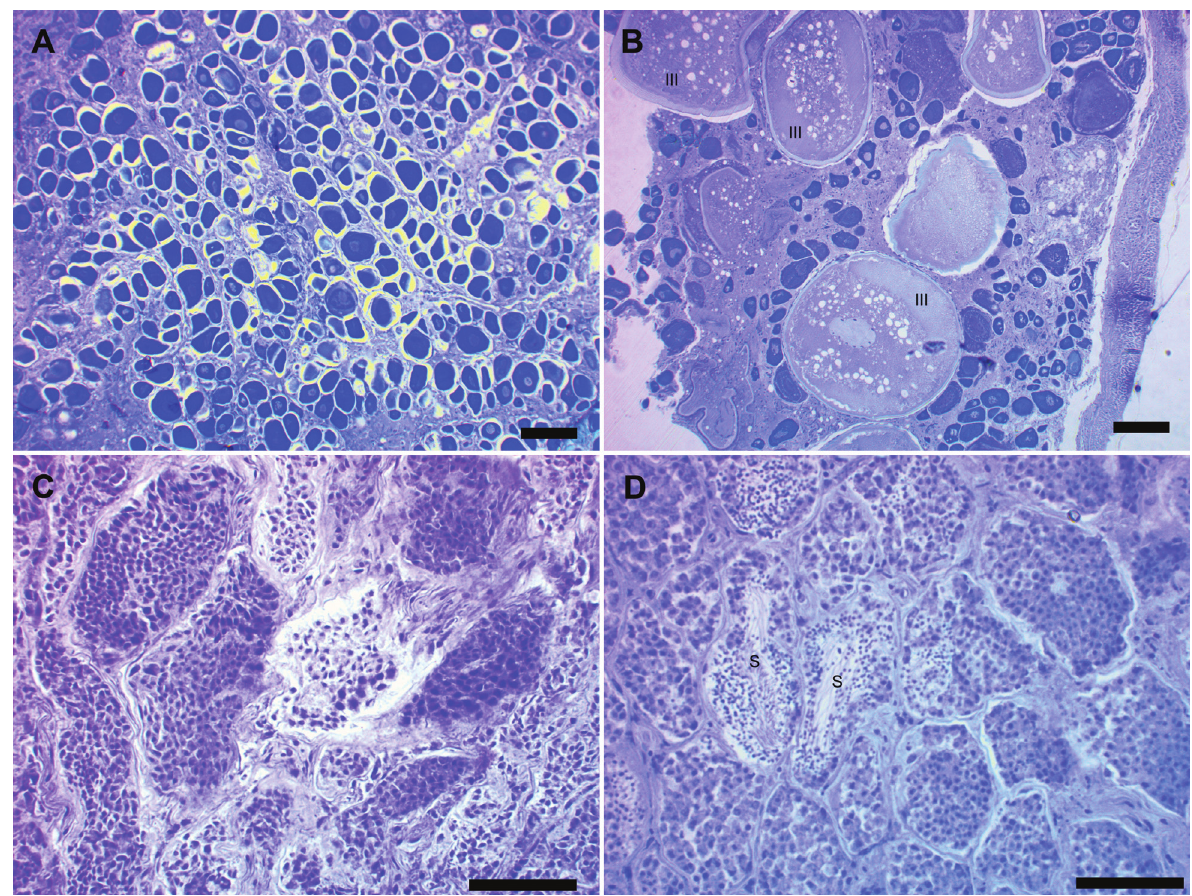
Figure 4. Histological sections of gonads of Parupeneus indicus from Fiji. ( A ) ovary of immature female (22.2 cm L only primary-growth oocytes; ( B ) ovary of mature female (23.6 cm L esis (III); ( C ) testis from an immature male (31.5 cm L with tailed spermatozoa (S); scale bars = 100 μm ( A and B ) or 50 μm ( C and D